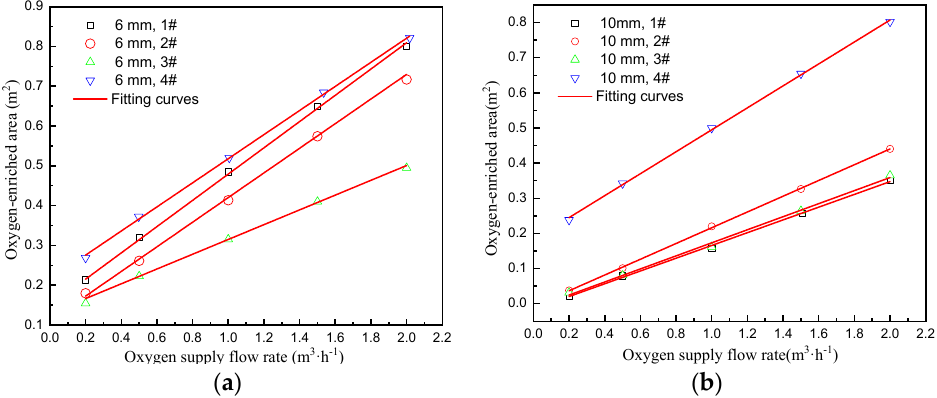
Figure 9. Oxygen-enriched area with different oxygen supply modes and oxygen flow rates in un-air-conditioned state. Table 5. The relationship between the oxygen-enriched area and oxygen flow rate in un-air-conditioned state.